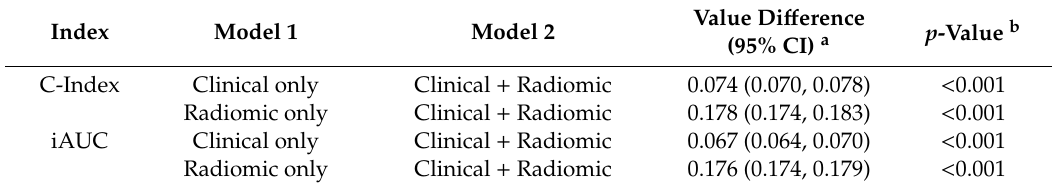
Table 4. Comparison of prediction performances measured using Harrell’s C-Index and iAUC